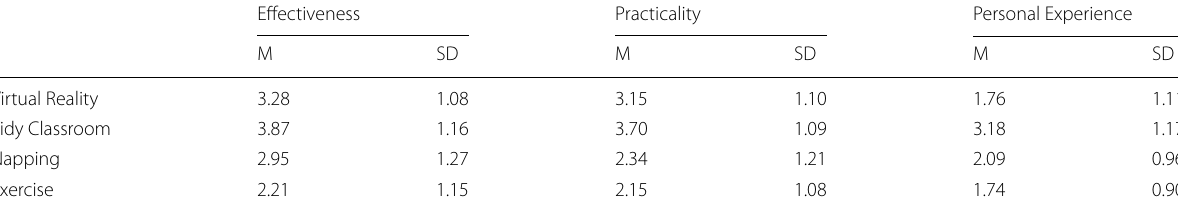
Table 4 Descriptive statistics for prior belief ratings for interventions in Experiment 2 Effectiveness